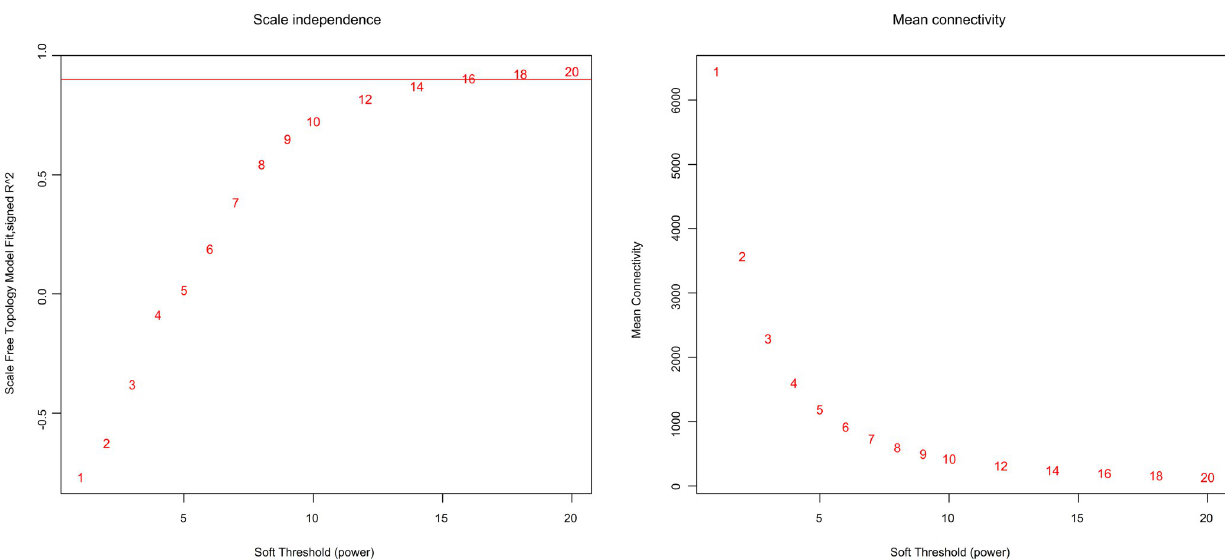
Fig 2. Selection of an appropriate soft threshold power of β . Left; the scale-free fit index of power ( β ) was estimated to be 16 based on the threshold limit of 0.9. Right; the mean connectivity versus soft-thresholding power.